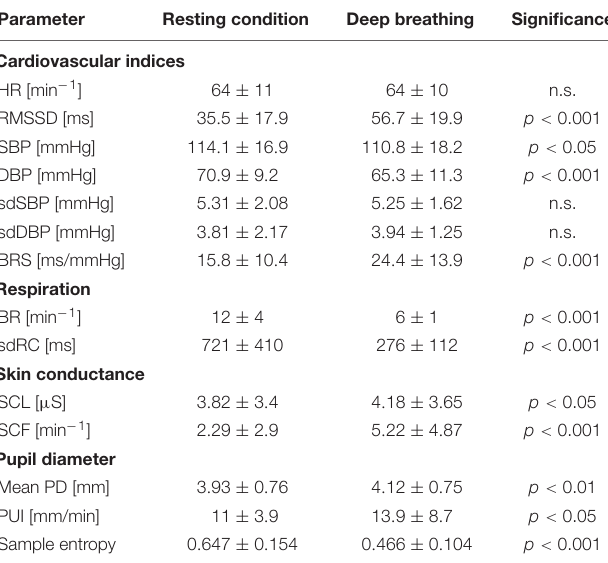
TABLE 5 | Influence of deep breathing test on autonomic indices and pupillary dynamics.